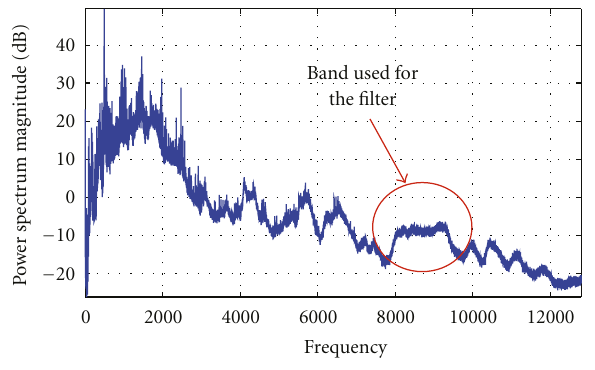
Figure 6: Power spectrum density of vibratory